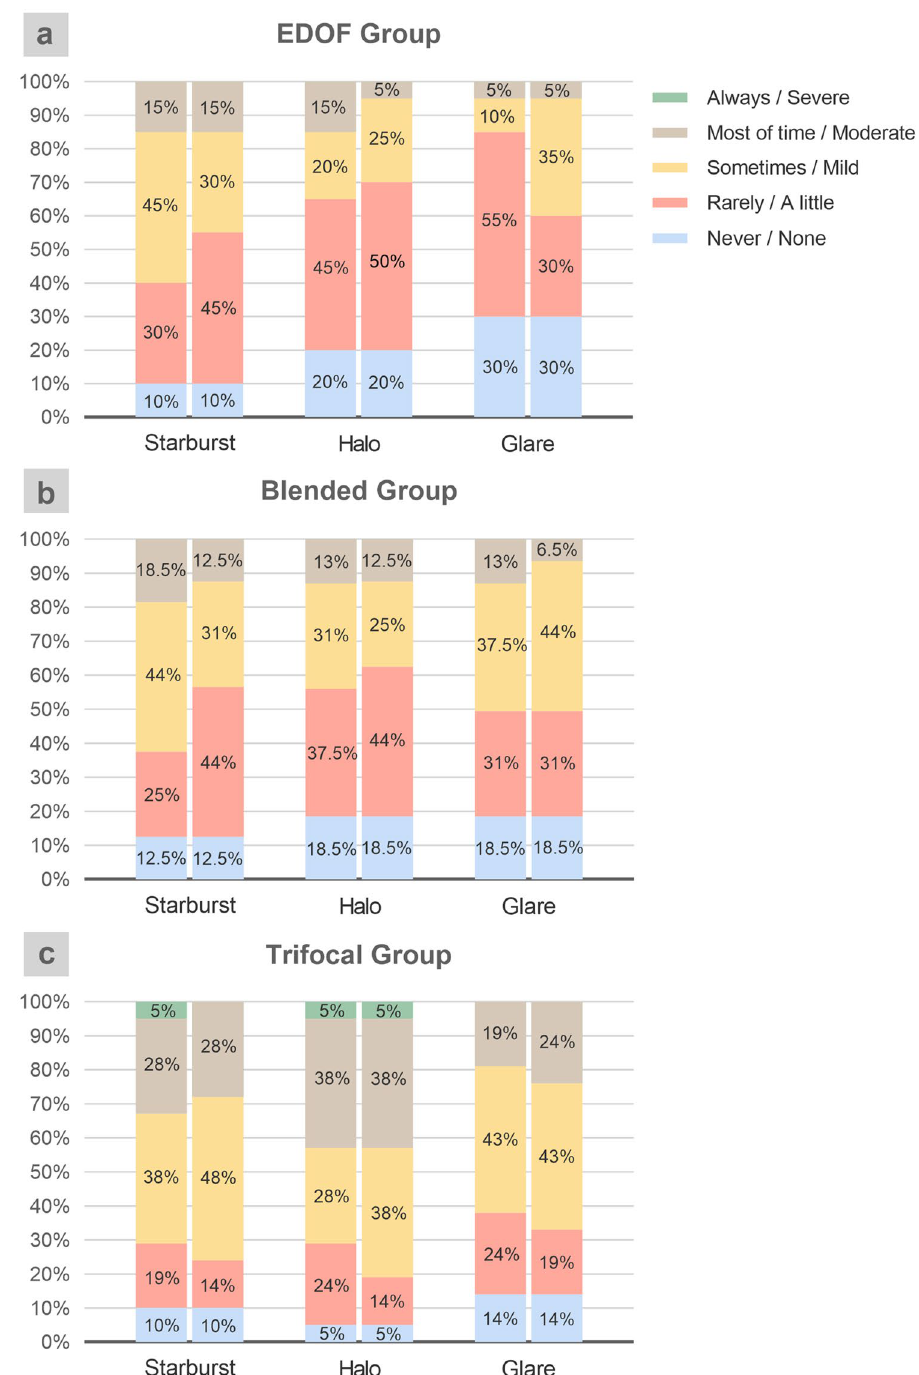
Figure 3. Results of the questionnaire regarding the perception of optical phenomenon in the EDOF group, blended group and trifocal group. The frequency and severity of starburst symptom in the EDOF group, blended group and trifocal group was not statistically significant different. The frequency and severity of halo symptom in the trifocal group was significantly severe than the EDOF group. The frequency of glare symptom in the trifocal group was significantly higher than the EDOF group. All outcomes were compared between the three groups. The first column of each optical phenomenon represents frequency, the second column represents